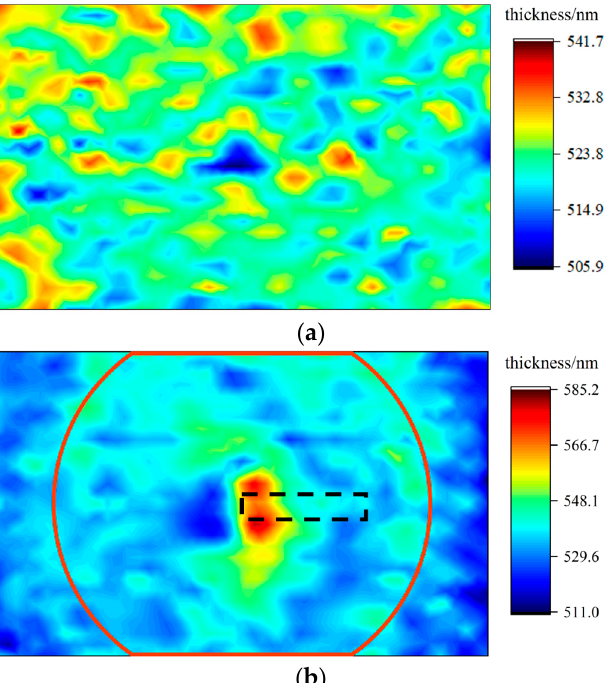
Figure 3. The contour map of the film thickness obtained from the reference group, ( a ) and airflow disturbance group ( b ) experiments. The dashed line is the relative position of the disturbance plate in the top view, and the area within the solid line is where the film thickness changes significantly.